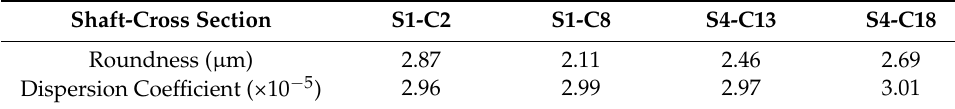
Table 3. Sections with similar discrete